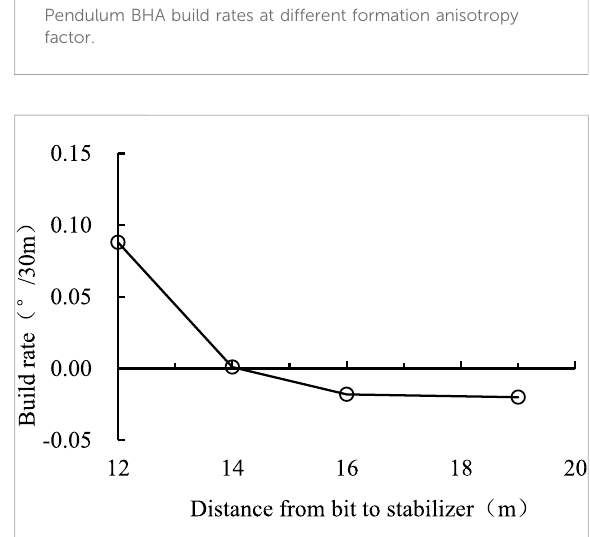
FIGURE 3 Pendulum BHA build rates at different WOB.